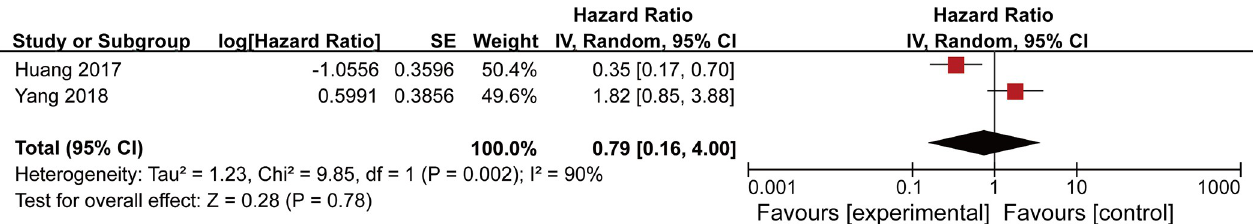
Fig 4. Forest plot showing the correlation between disease-free survival and secreted protein acidic and rich in cysteine expression in patients with hepatocellular carcinoma.